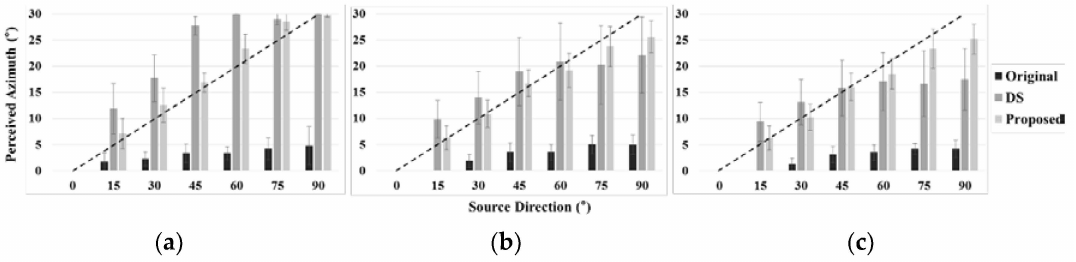
Figure 12. Comparison of the perceived azimuth depending on the direction of the source in three different environments: ( a ) anechoic; ( b ) convolutive; and ( c ) real reverberant room.